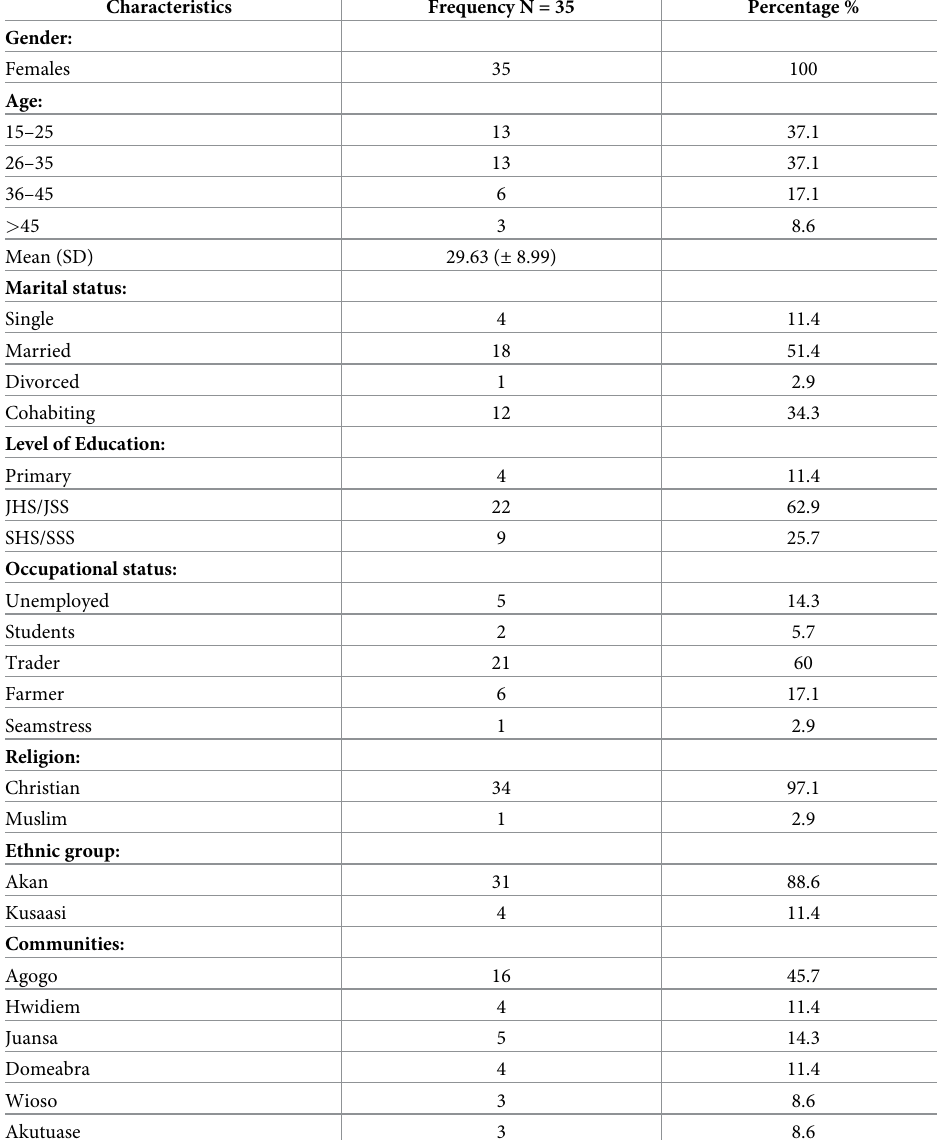
Table 1. Socio-demographic profile of study participants.